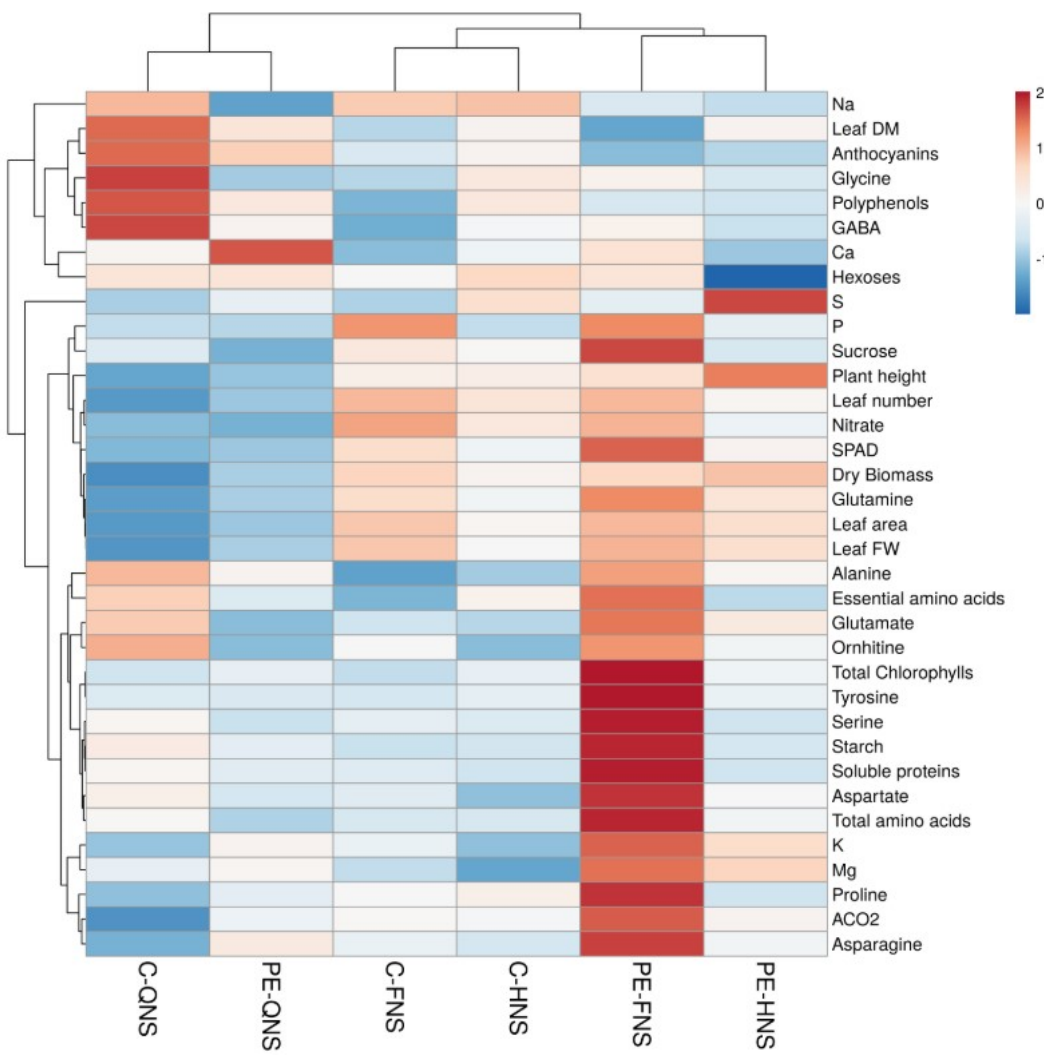
Figure 1. Cluster heat map analysis summarizing plant responses to tropical plant extract (PE) biostimulant or untreated control (C) and different nutrient solution concentrations: full-strength (FNS), half-strength (HNS), and quarter-strength (QNS). Figure was generated using the https://biit.cs.ut.ee/clustvis/ online program package with Euclidean distance as the similarity measure and hierarchical clustering with complete linkage.